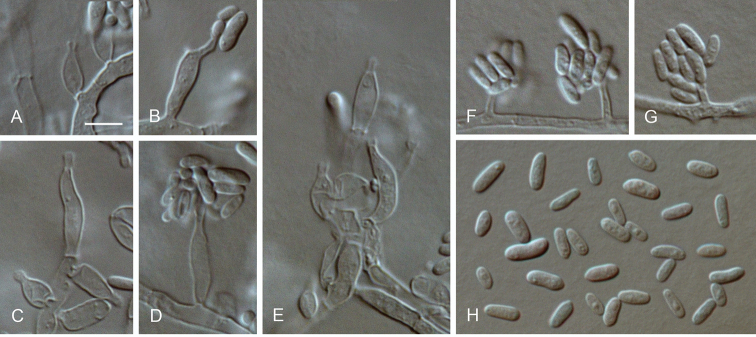
Cadophora
novi-eboraciA–G conidiophores and conidiogenous H conidia A–H from SNAA–HLM. Scale bar: 5 μm (A applies to B–H).